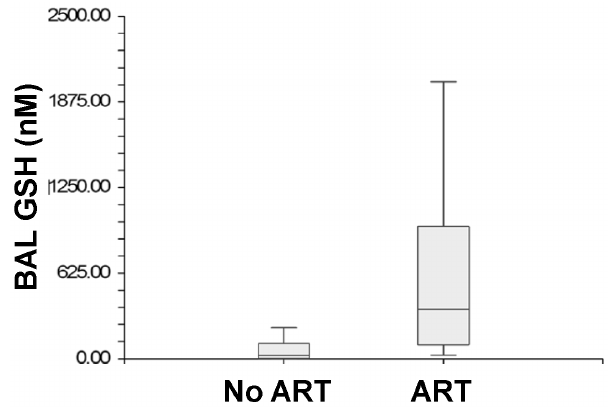
Figure 1. Box Plots of Glutathione Levels in Bronchoalveolar Lavage between non-HIV and HIV-infected Subjects.